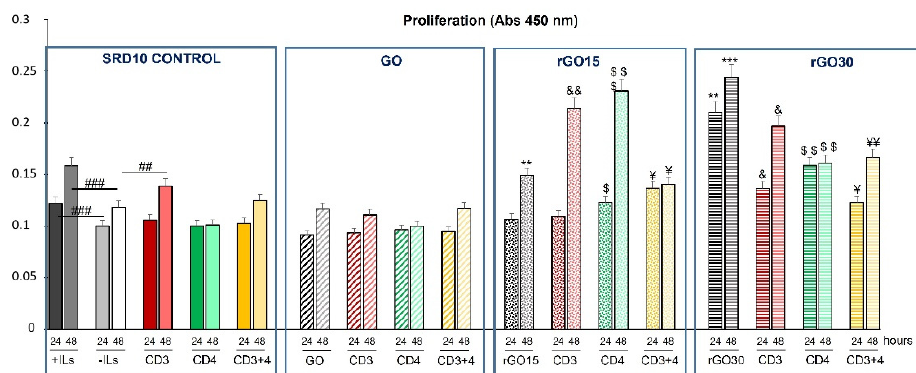
Figure 4. Effect of GO, rGO15 and rGO30 on the proliferation of CD4 + Th2 SR.D10 cell line after 24 h or 48 h of treatment with 5 µg/mL of these nanostructures, evaluated by mitochondrial activity assays under basal and stimulated conditions. Statistical significance: ### p < 0.005 (compared to positive control cells without material cultured in the presence of ILs at 24 and 48 h), ## p < 0.01 (compared to control cells without material cultured in the absence of ILs activated through CD3); ** p < 0.01 (comparison between rGO15 and rGO30 to control); *** p < 0.005; & p < 0.05, && p < 0.01 (compared to control cells with rGO15 and rGO30 in the absence of ILs activated through